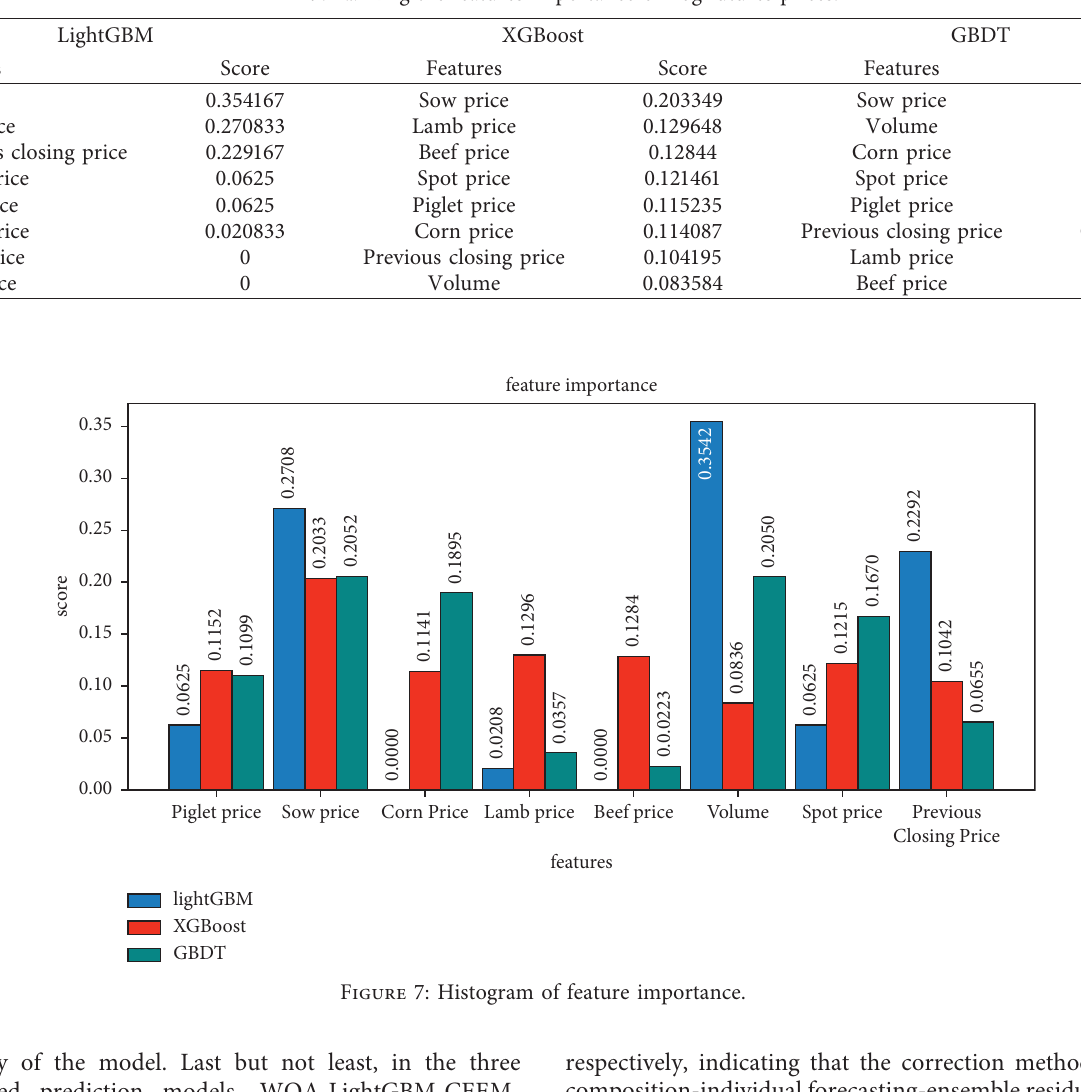
Table 9: Ranking the features importance of hog futures prices.